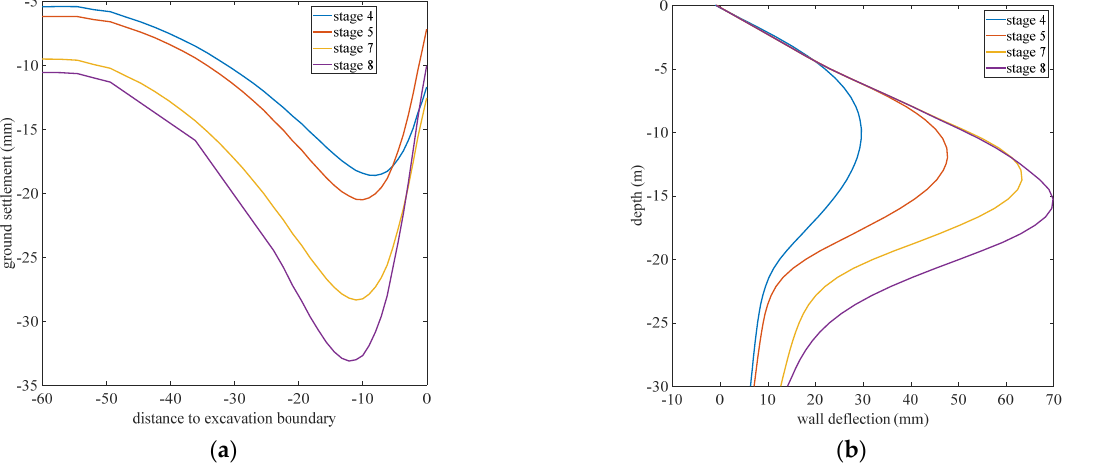
Figure 2. Deformation curve of deterministic model: ( a ) ground settlement curve; ( b ) wall deflection curve.